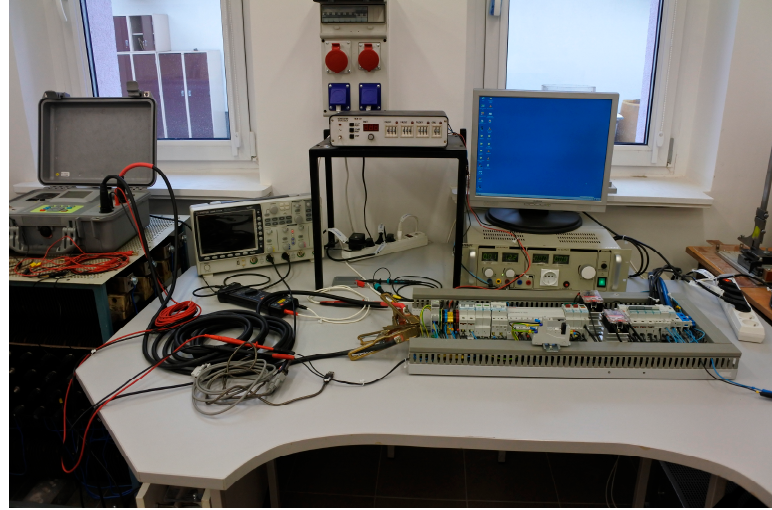
Figure 3. Photograph of the test bench used in the study.